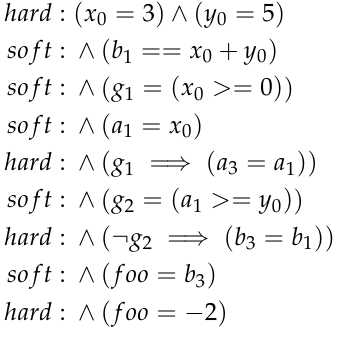
Figure 6. Constraints added in the first